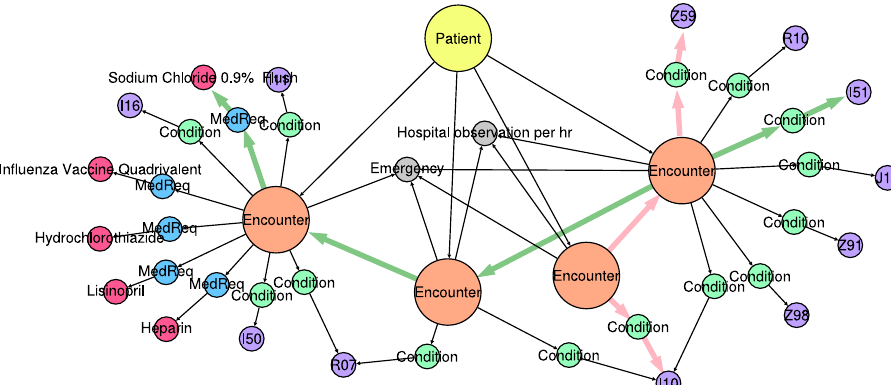
Fig. 6 Examples of 2- and 3-paths in a patient trajectory. A 2-path from the ConditionType node I10 of the fi rst Encounter node to ConditionType node Z59 of the second Encounter node is highlighted in pink. A 3-path from the ConditionType node I51 of the second Encounter node to the MedicationType node Sodium Chloride 0.9% of the fourth Encounter node is highlighted in